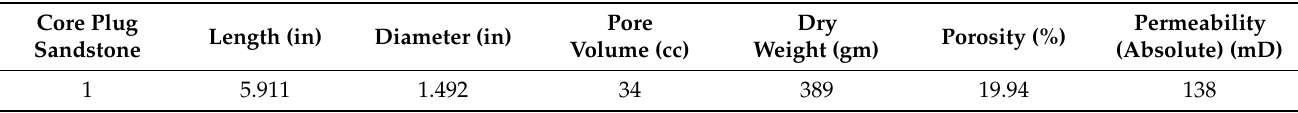
Table 4. Core Data and Properties.